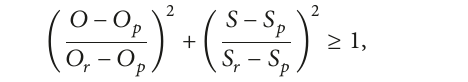
Figure 3: Contact force due to an infinitesimal overlap around points 𝑃𝑐 and 𝑃𝑡 based on the potential function method